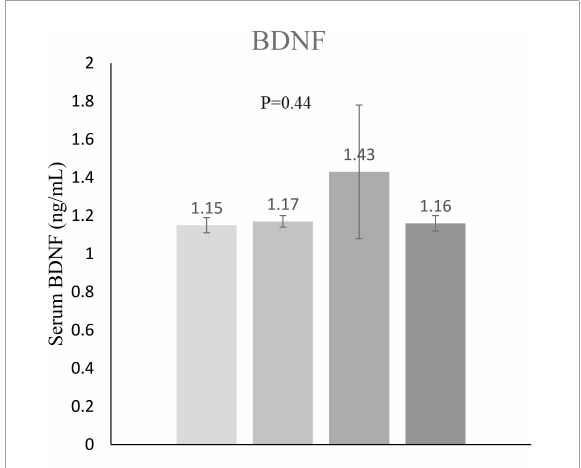
FIGURE2 Serum BDNF values in different phenotypes of serum triacylglycerol concentration and waist circumference. Value of serum BDNF in phenotype 1 (enlarged waist circumference and high triglyceride concentrations) was 1.15 ± 0.04 (mean ± SE); in phenotype 2 (enlarged waist circumference and normal triglycerides) was 1.17 ± 0.03; in phenotype 3 (normal waist circumference and high triglyceride concentrations) was 1.43 ± 0.35; and in phenotype 4 (normal waist circumference and normal concentrations) was 1.16 ±